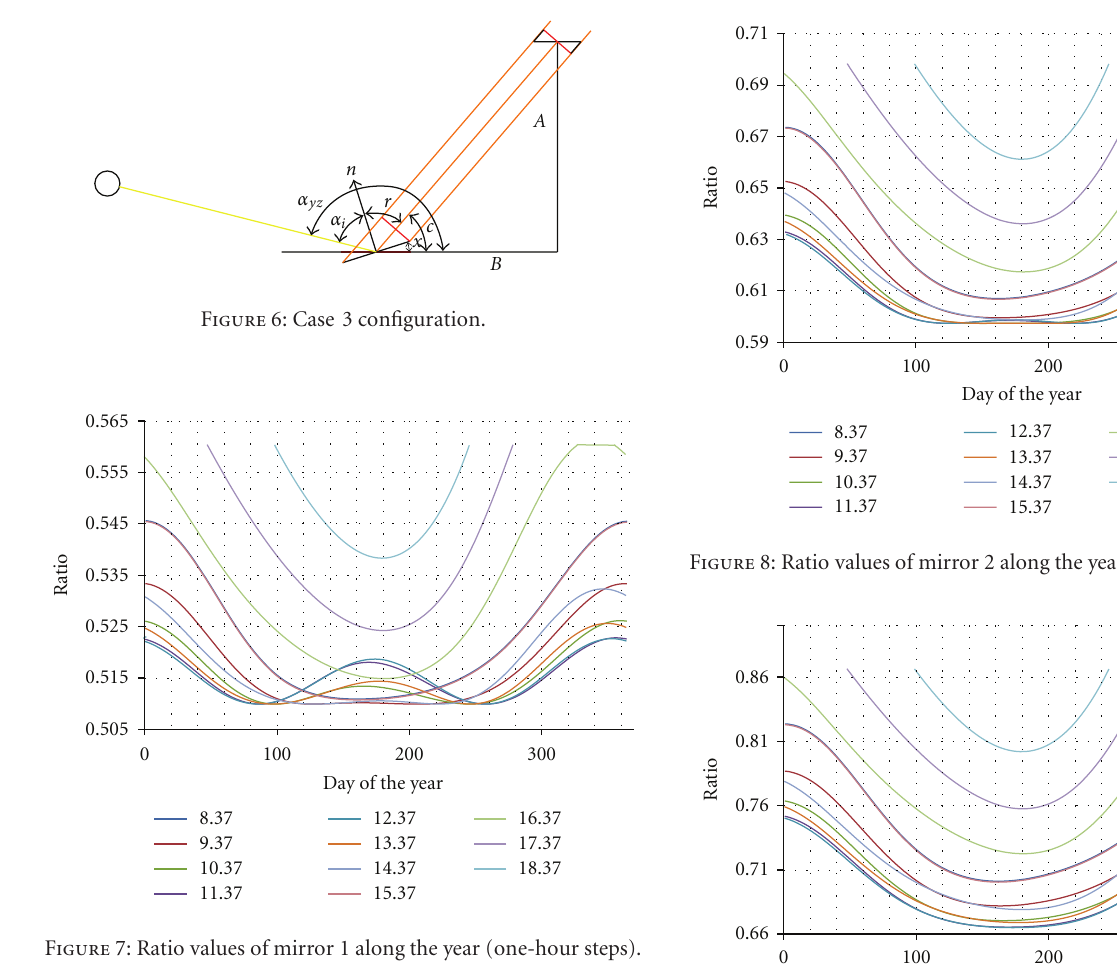
Figure 7: Ratio values of mirror 1 along the year (one-hour steps).